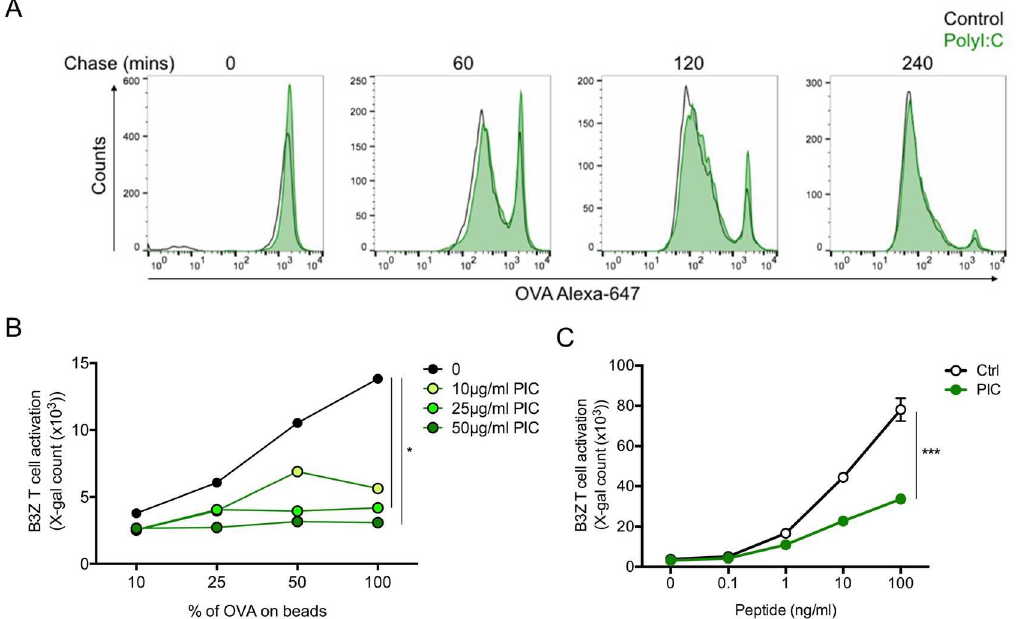
Fig 1. PolyI:C pre-treatment impairs the capacity of DCs to cross-presentantigen. ( A ) Degradation of bead- bound OVA was measured in DCs treated with nothing(Control) or polyI:C (25 μ g/mL). Pre-treated DCs were pulsed with bead-bound OVA for 30 min at 18˚C and chased for 0, 60, 120 or 240 min. The amount of OVA present on internalisedbeadswas evaluatedusing an anti-OVA polyclonal antibodyby FACS. ( B ) Cross-presentationof bead- bound OVA by DCs pre-treatedwith different concentrations of polyI:C for 20 h. After incubation with bead-boundOVA, cells were washedand incubatedwith B3Z T cells at a 1:1 ratio for 20 h. Proliferation was measuredby detectionof ß- galactosidase activity in the cells. ( C ) Presentation of the solubleOVA peptide. DCs were treated with nothing(Ctrl) or polyI:C (25 μ g/mL) for 20 h and then loadedwith different concentrations of the SIINFEKL peptidefor 3 h, washedand incubatedwith B3Z T cells at a 1:1 ratio for 20 h. Proliferationof B3Z T cells was evaluatedby detection of ß- galactosidase activity in the cells. Error bars represent SEM. ** p value < 0.001. Data are representative of 4